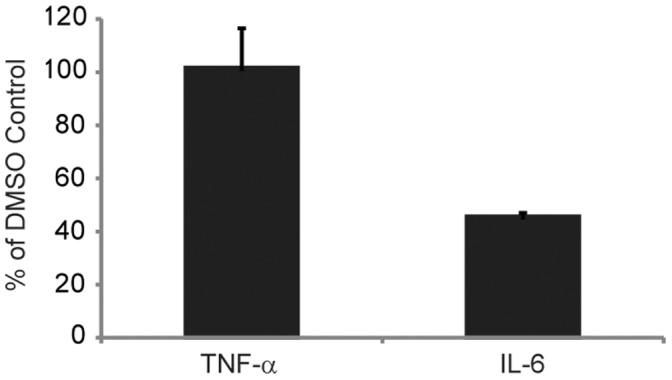
Effect of Dynasore® on macrophage TNF-α and IL-6 secretion induced by LTA plus Hb. HeNC2 cells were preincubated with either 40 µM Dynasore® or an equivalent amount of the solvent, DMSO, for 30 min and then stimulated with LTA plus Hb (2 µg/ml and 50 µg/ml, respectively) for 6 hours.TNF-α and IL-6 concentrations were analyzed by ELISA. These results denote mean +/− standard error (n = 3) and are representative of three independent experiments.